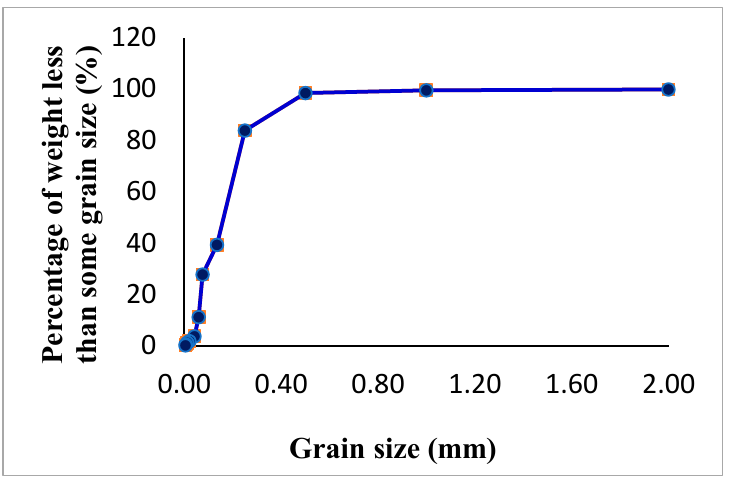
Figure 3. Particle size distribution curve of sand. The dots are the measured data. Assuming that, between every two dots, the change is linear, they are connected by a line.